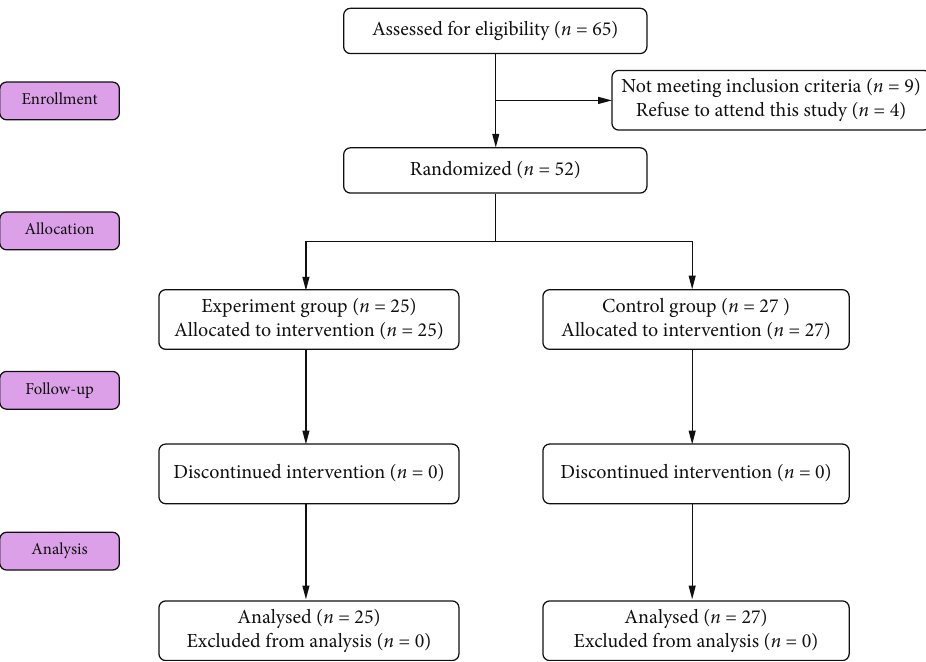
Figure 2: Flow diagram of subjects through the